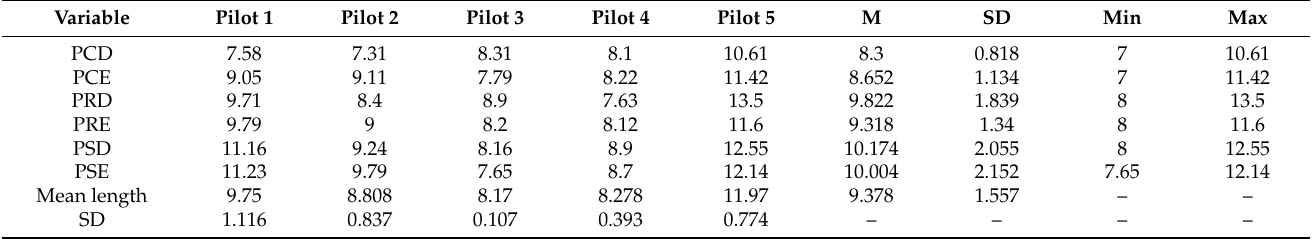
Table 1. The length of the circuit for individual pilots in flights on an airplane with a single piston engine. Variable